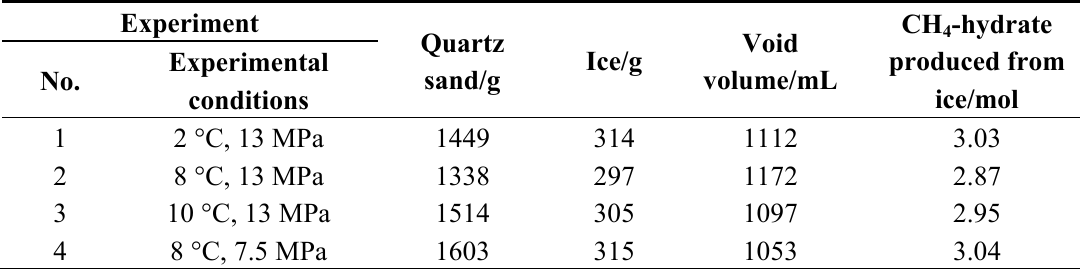
Table 1. Sediment preparation and CH sediment and hydrate